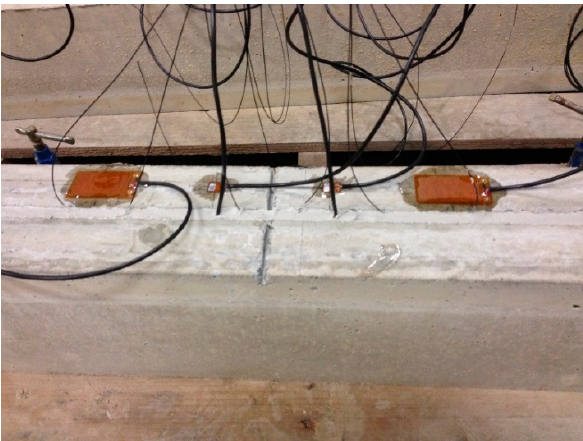
Figure 4. PZT-instrumented NSM-FRP specimen.